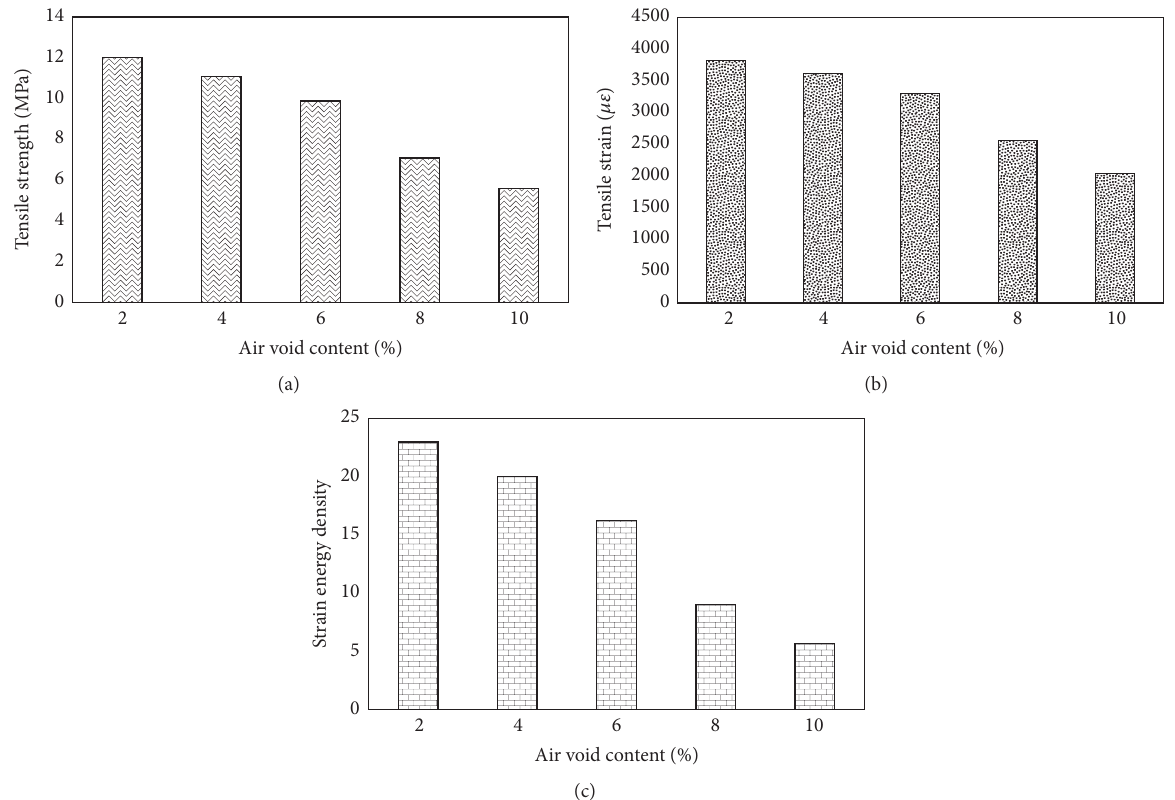
Figure 8: Testing results at different air void contents: (a) tensile failure strength; (b) tensile failure strain; (c) strain energy density.